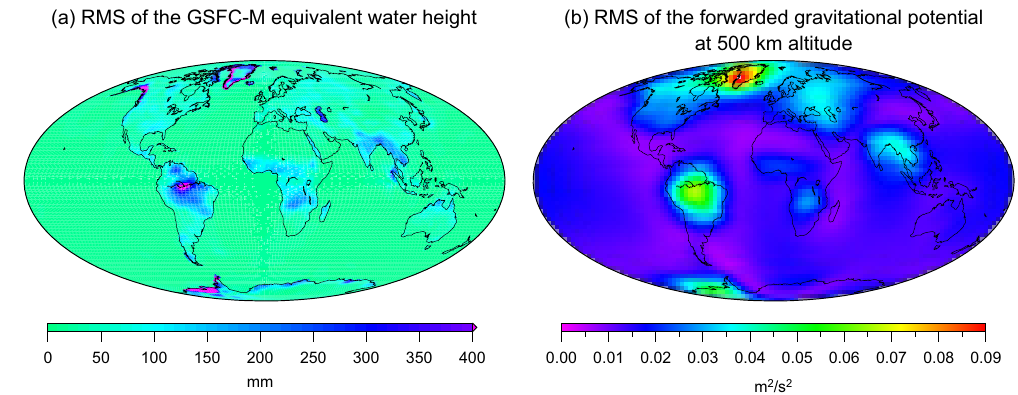
Figure 3. ( a ) Spatial patterns of the root-mean-square (RMS) of the series of each one of the 41,168 equivalent water height panels from GSFC-M based on the period of January 2003 to December 2015. ( b ) Spatial patterns of the RMS of the forwarded gravitational potential at 500 km altitude according to the radial integral in Equation (20) using the GSFC-M monthly fields of equivalent water